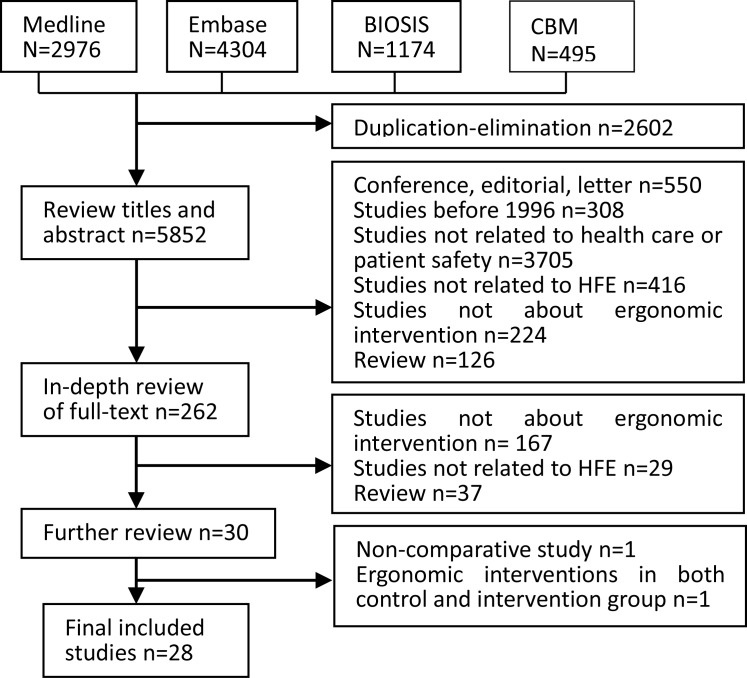
Flow Diagram for searching and selection processes.